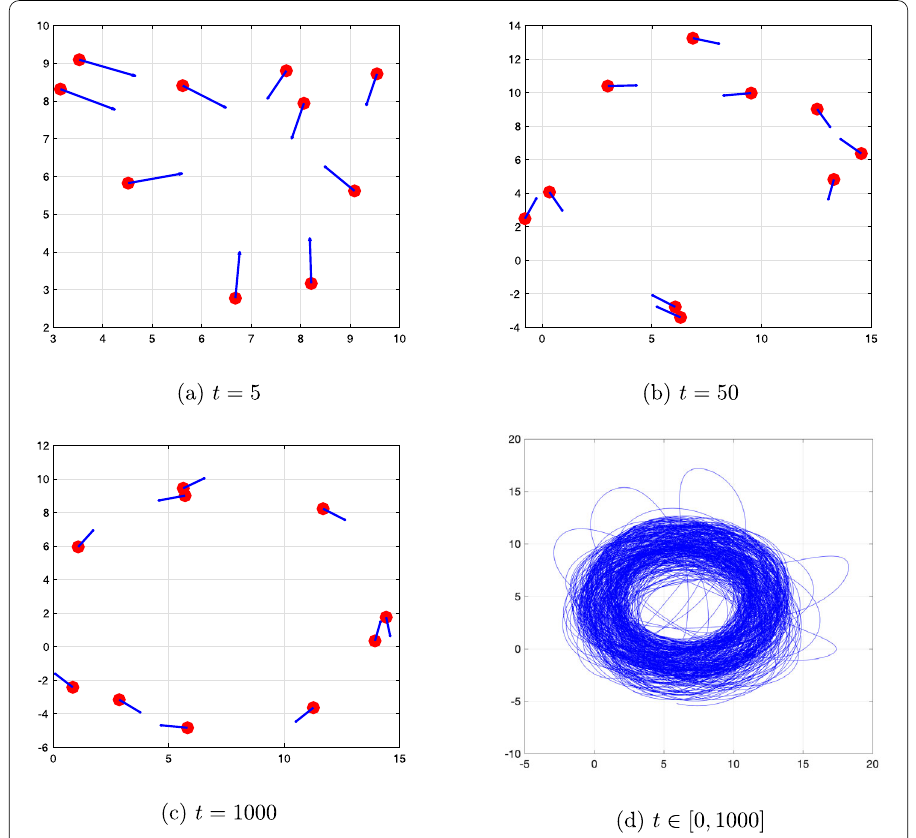
Figure 4 Simulation of the second-order swarming model with time delay ( τ = 5) for five agents, N = 10 in time t ∈ [0,1000]. The corresponding parameters are given as α = 0.7, β = 0.5, C a = 5, l a = 100, C r = 1, and l r = 1. The position of each agent is depicted by a circle and the velocity is represented by a vector at agent’s position